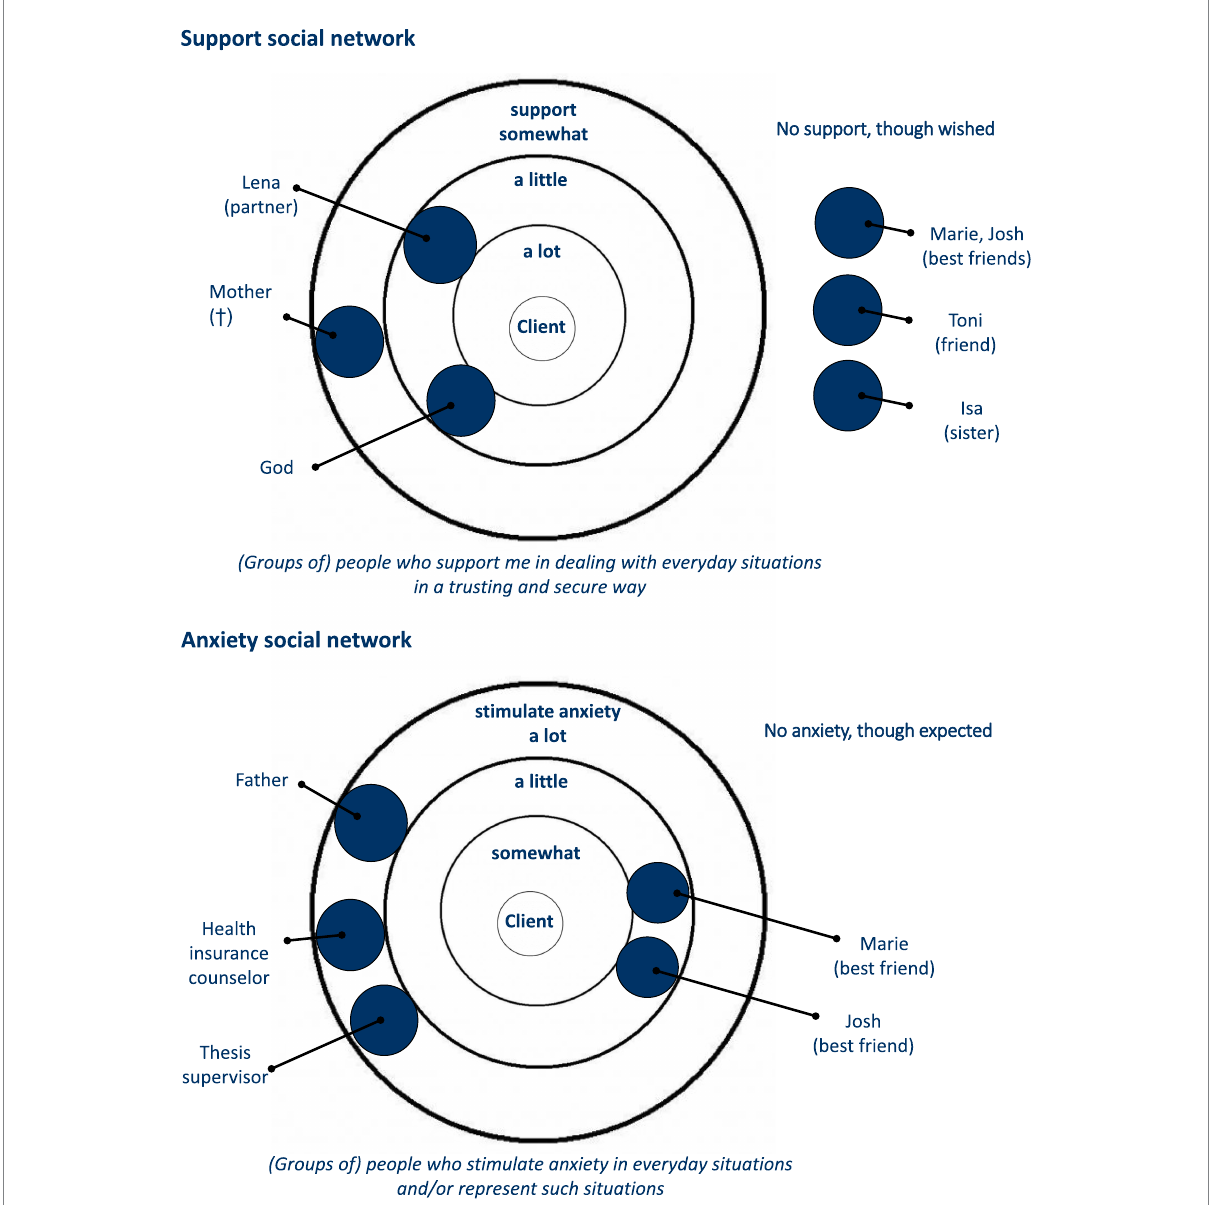
FIGURE 3 Support and anxiety social network (Schweitzer et al., 2020; Hunger,